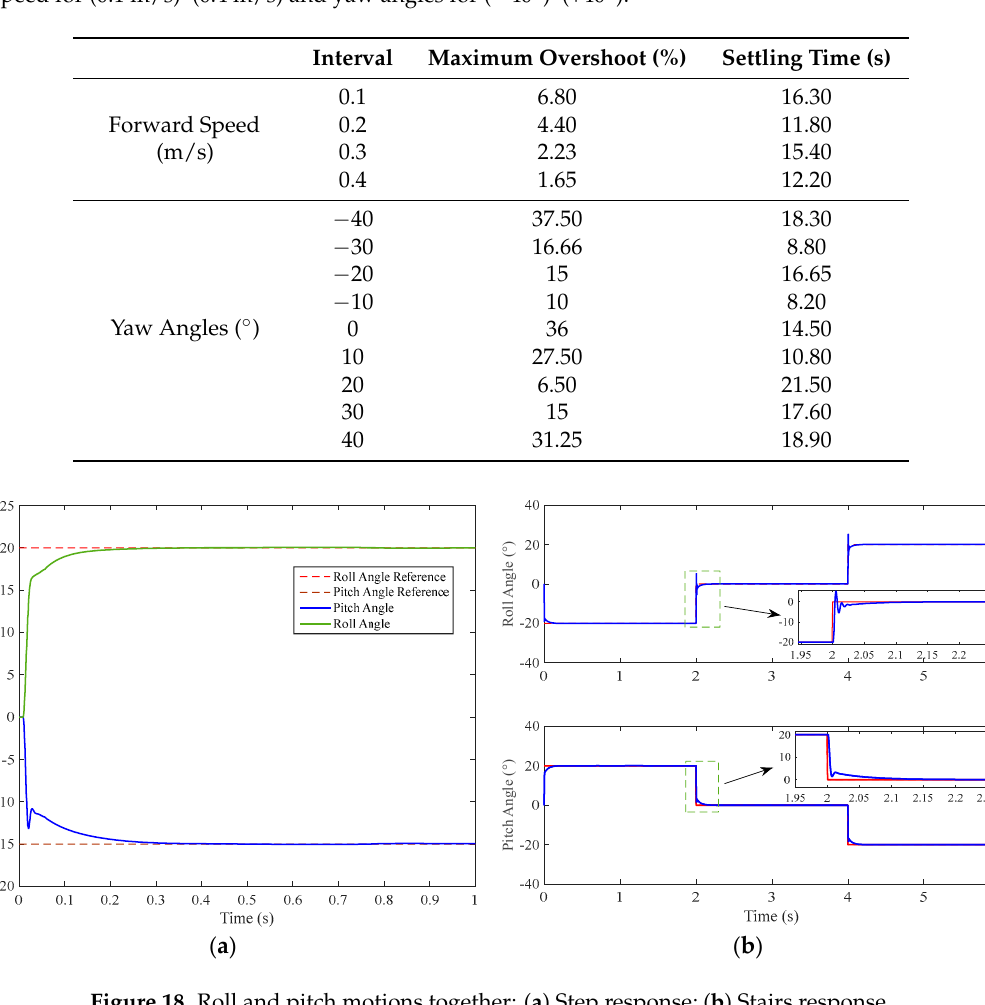
Table 1. The closed loop control performance: Maximum overshoot (%) and settling time (s) of forward speed for (0.1 m/s)–(0.4 m/s) and yaw angles for ( − 40 ◦ )–(+40 ◦ ).